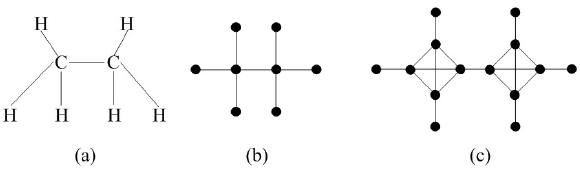
Figure 1: (a) molecular construction of C 2 H 6 , (b) molecular graph of C 2 H 6 , (c) line graph of subdivision of C 2 H 6